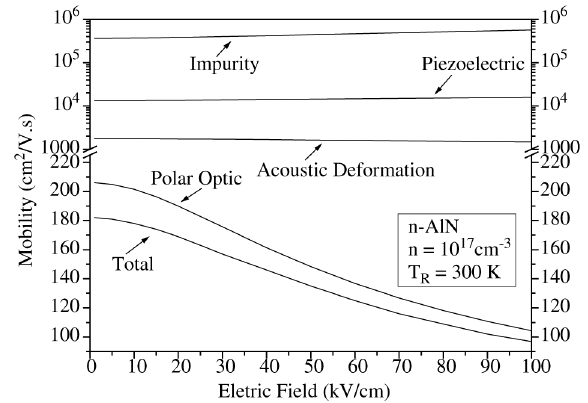
Figure.2. Electric field dependence of the different contributions to the electron mobility in wurtzite n-InN. The lattice temperature is T = 300 K and n = 10 17 cm -3 . 0